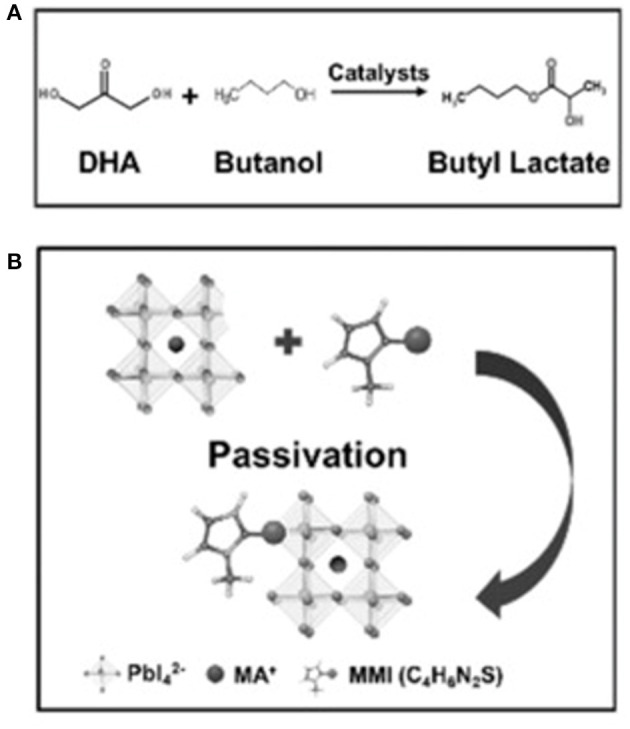
(A) The conversion of DHA and butanol into butyl lactate over the catalyst. (B) The passivation of MAPbI3 (Dong et al., 2020b) © 2020 Wiley-VCH Verlag GmbH & Co. KGaA, Weinheim .